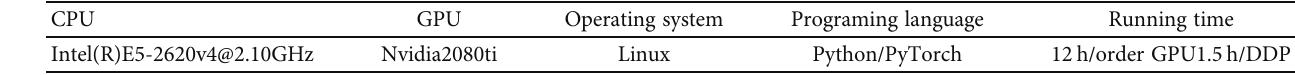
Table 4: Experimental software and hardware environment.